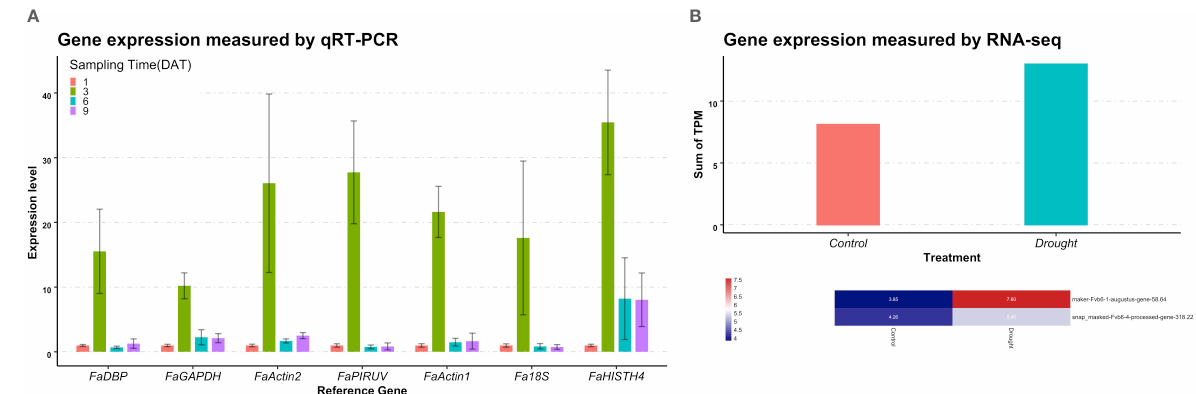
Figure 6. Gene-expression level of FaBBX28 under drought stress. ( A ) The expression level normalized by the seven candidate reference genes. The expression levels are represented as the mean ± standard error. The standard error was calculated from the expression levels of biological replicates under drought stress. ( B ) The expression level determined by RNA-seq under drought